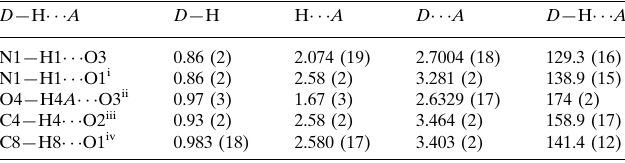
Hydrogen-bond geometry (A˚ , (cid:1)